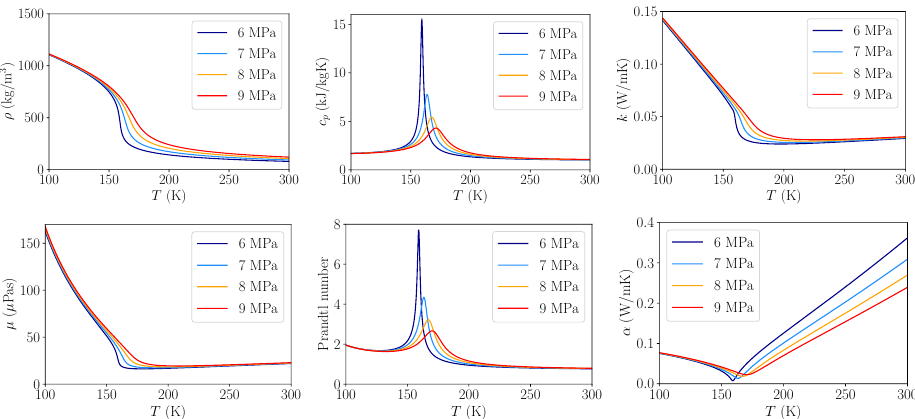
Figure 1. Near-critical fluid properties, oxygen data from CoolProp